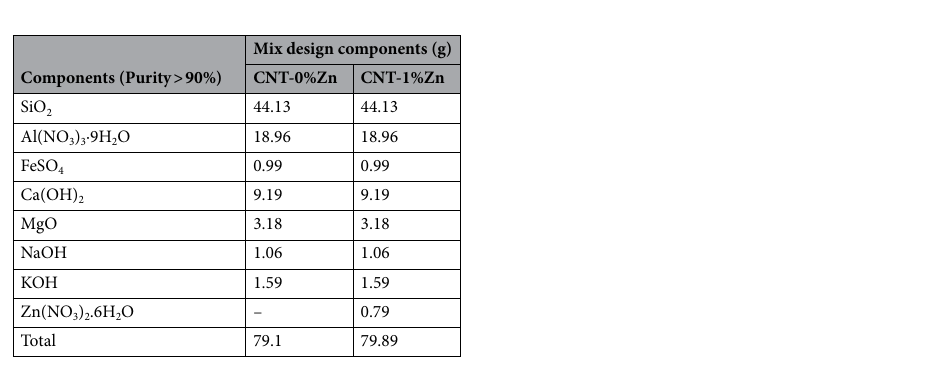
Table 6. Solid phase composition of controlled samples (CNT).